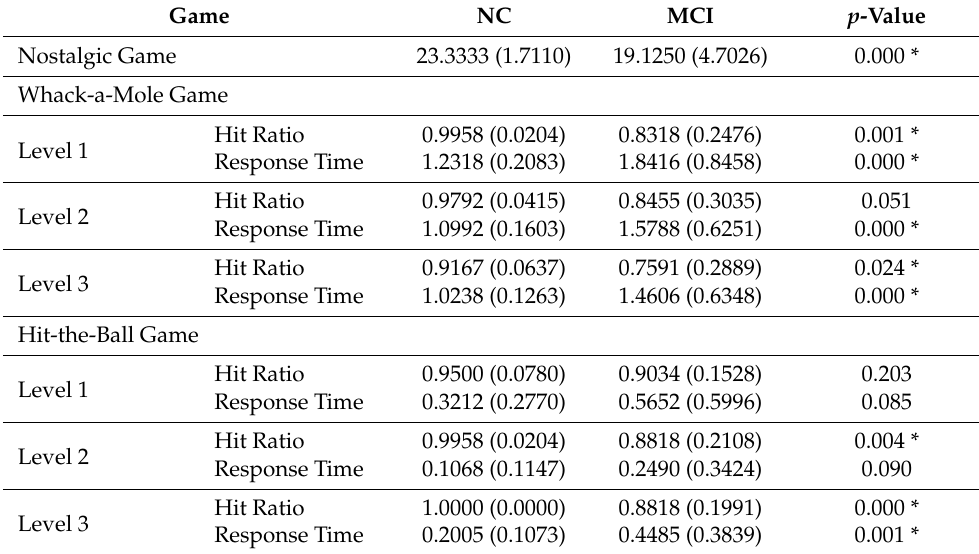
Table 6. Game Results and Statistical Analysis between the two